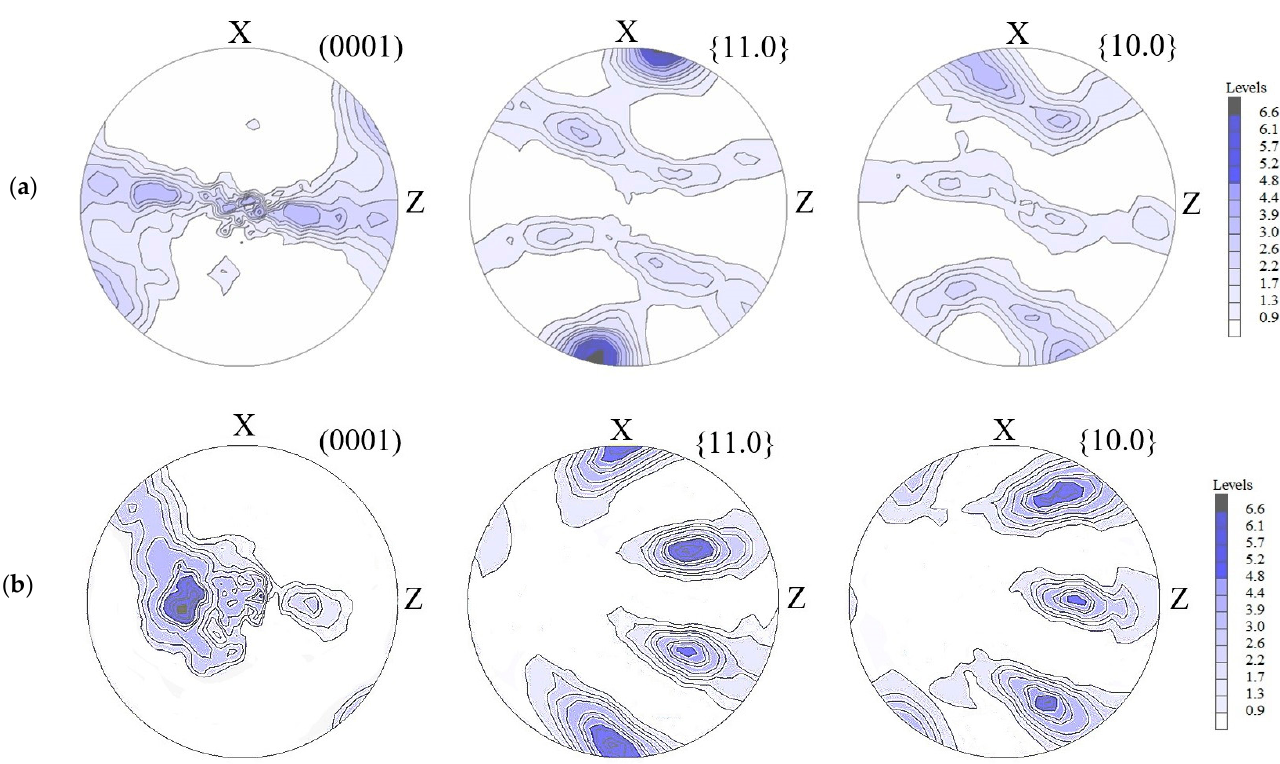
Figure 4. (0001), {11.0} and {10.0} DPFs of the α -phase in the XZ-section for ( a ) the ECAP-processed billet and ( b ) the ECAP-processed billet after upsetting along the Z direction. Outer directions are indicated near the DPFs.